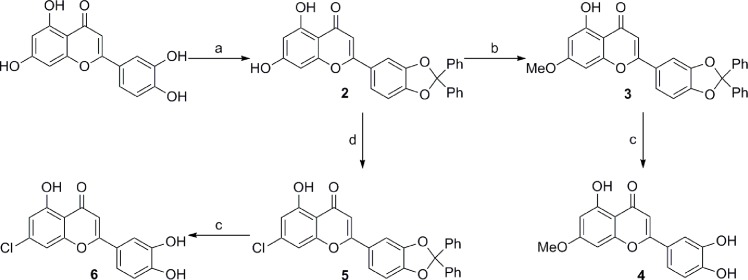
Reagents and conditions: (a) 2.1 equivalents Ph2CCl2, 2 equivalents DIPEA, Dioxane/NMP, 2 x 30 min, microwave 180°C. (b) 1.2 equivalents MeI, 1.4 equivalents K2CO3, DMF, 18 h, RT. (c) AcOH/H2O 4:1, 1 h, microwave 190°C. (d) 3.3 equivalents POCl3, DMF, 5 h, 130°C.